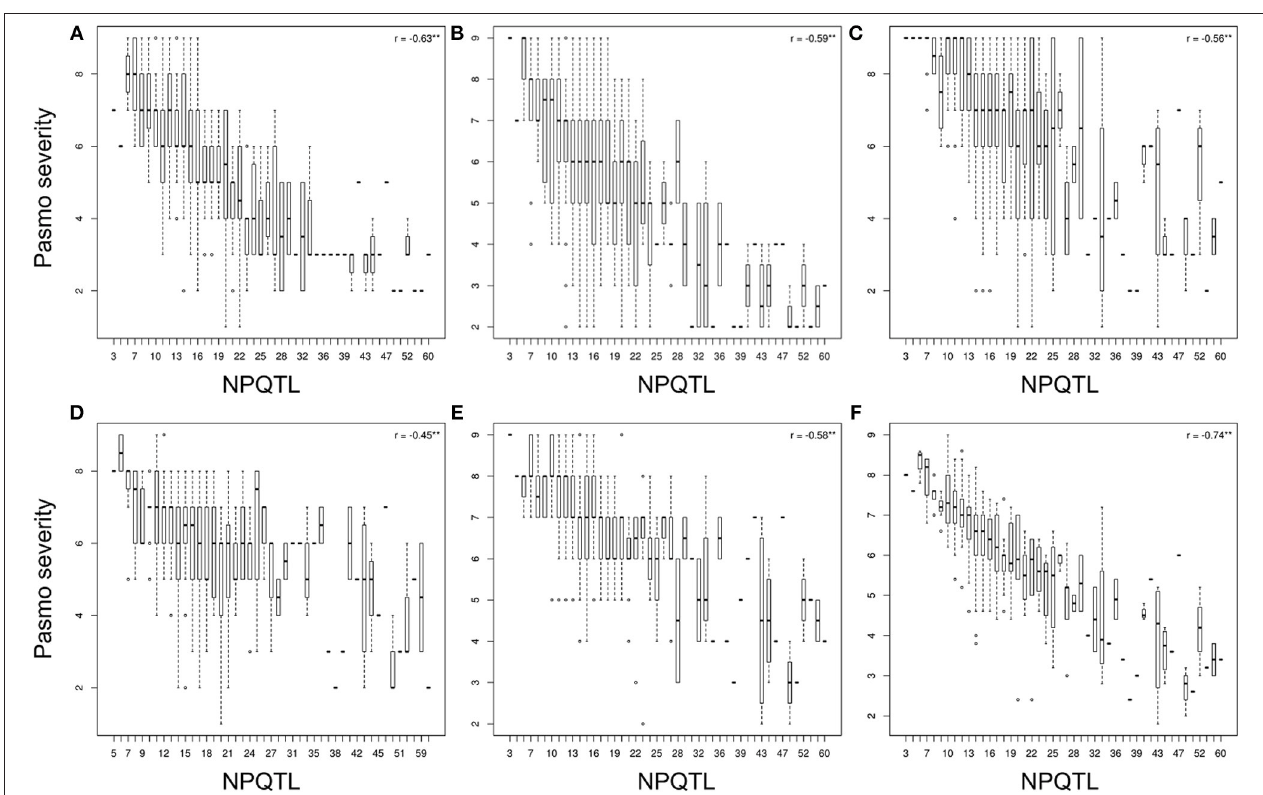
FIGURE 4 | Box plots of the number of QTL with positive-effect alleles (NPQTL) in relation to pasmo severity during 2012-2016 (A–E) and average pasmo severity across 5 years (F) ; ** indicates statistical significance at the 1% probability level.